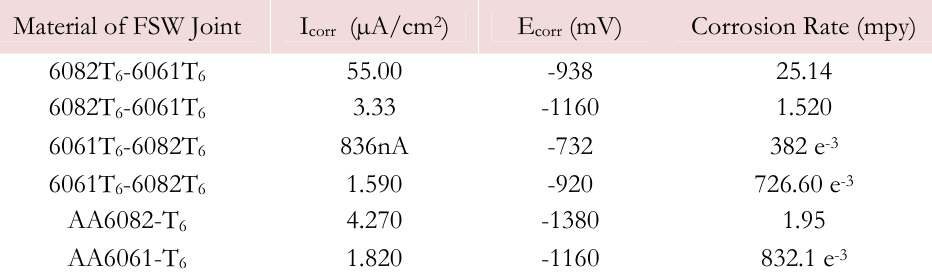
Table 5: Result analysis of corrosion test.